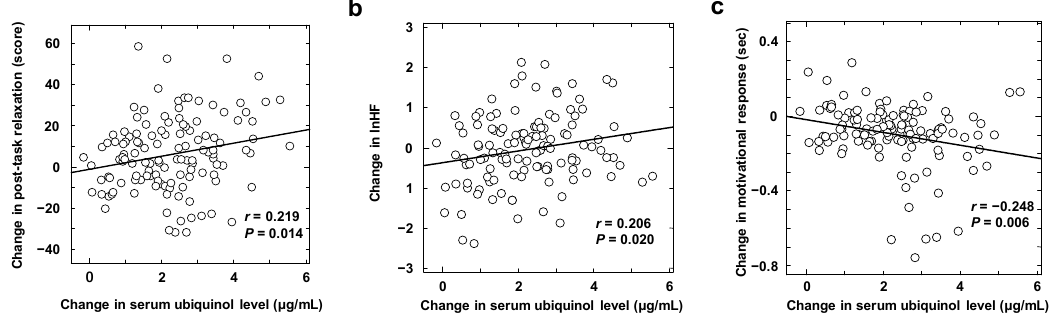
Figure 1. Correlation with change in serum ubiquinol concentration. Visual analogue scale-based post-task relaxation ( a ), log-transformed high-frequency component power (lnHF) ( b ), and motivational response of cognitive task ( c